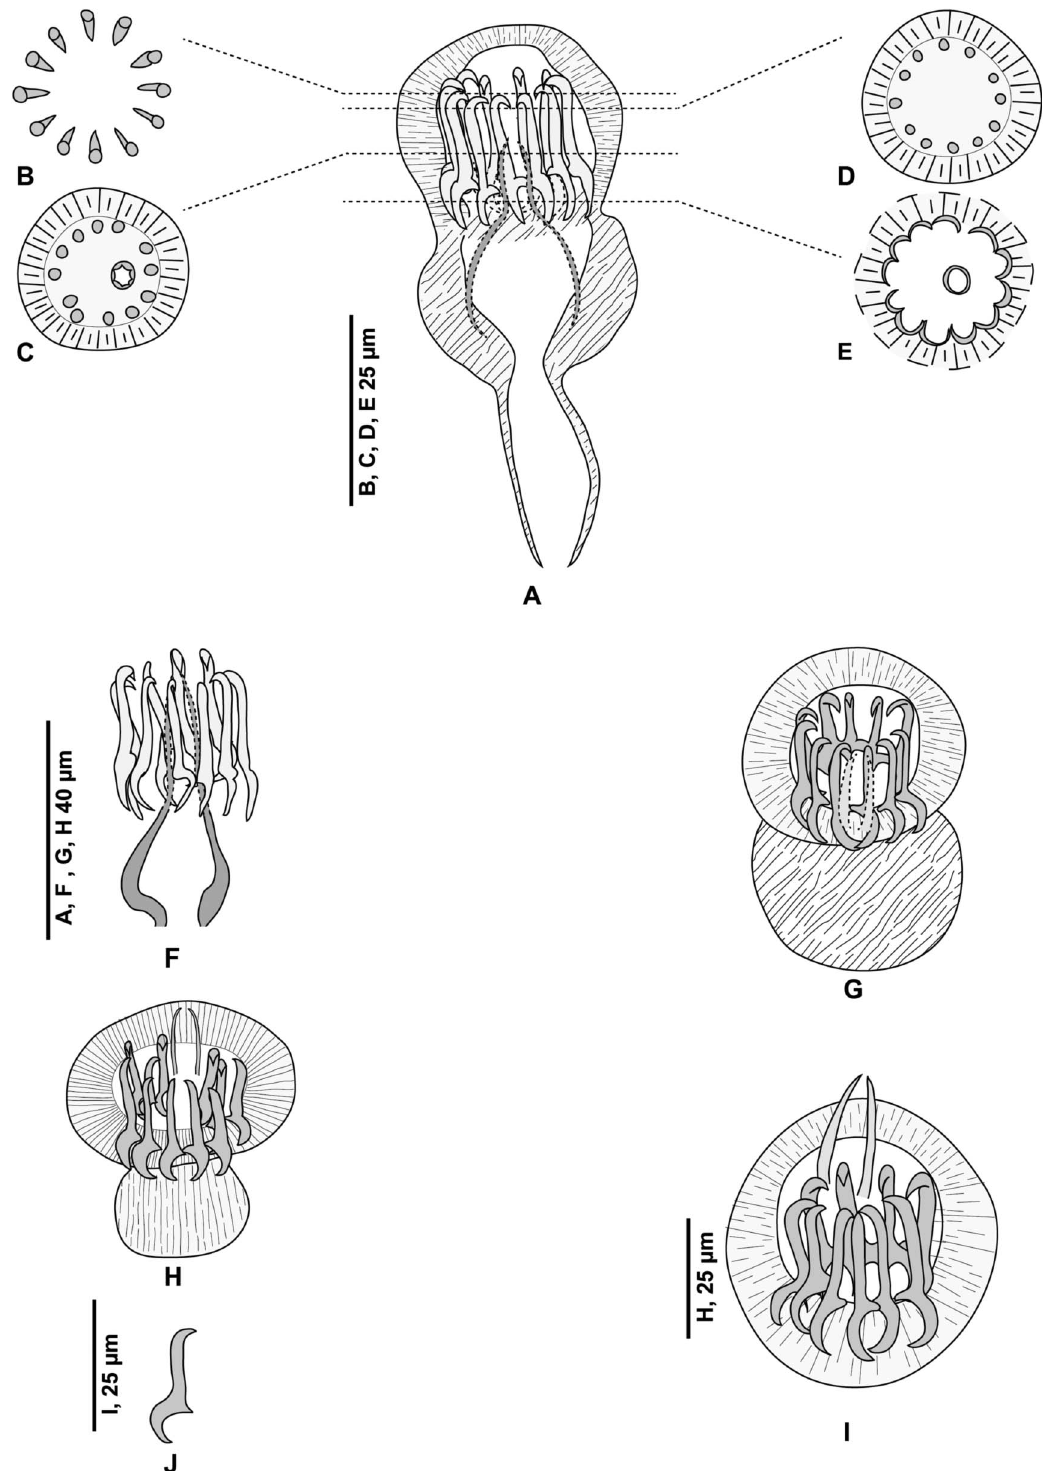
Figure 3. Pseudaxine trachuri , genital atrium shown laterally and in different optical sections and the variable position of the stylet. (A) Genital atrium, lateral view, MNHN HEL1284; (B – E), optical sections of a genital atrium in perfect apical view; the level of these sections are shown on the lateral view, MNHN HEL1285. (F) Lateral view of the atrium showing only the sclerotised parts, MNHN 306HG, Box 43, slide 51; (G – I) various views at different orientations, MNHN HEL1286, MNHN HEL1287, MNHN HEL1288. (J) One spine, MNHN